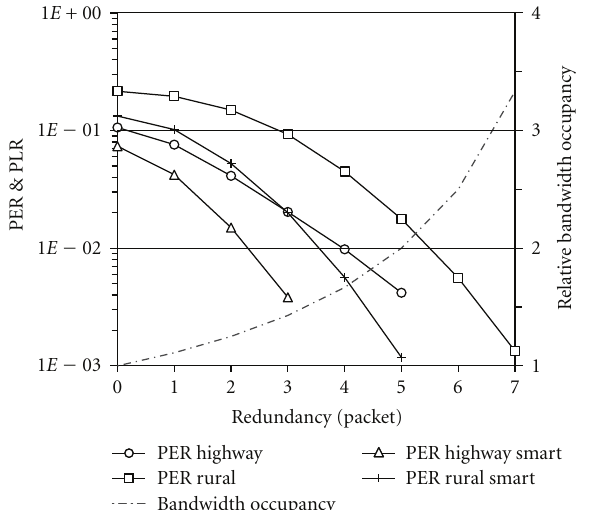
Figure 11: PER, PLR, and bandwidth occupancy versus redundancy with RSE (10, k ) in urban environment.